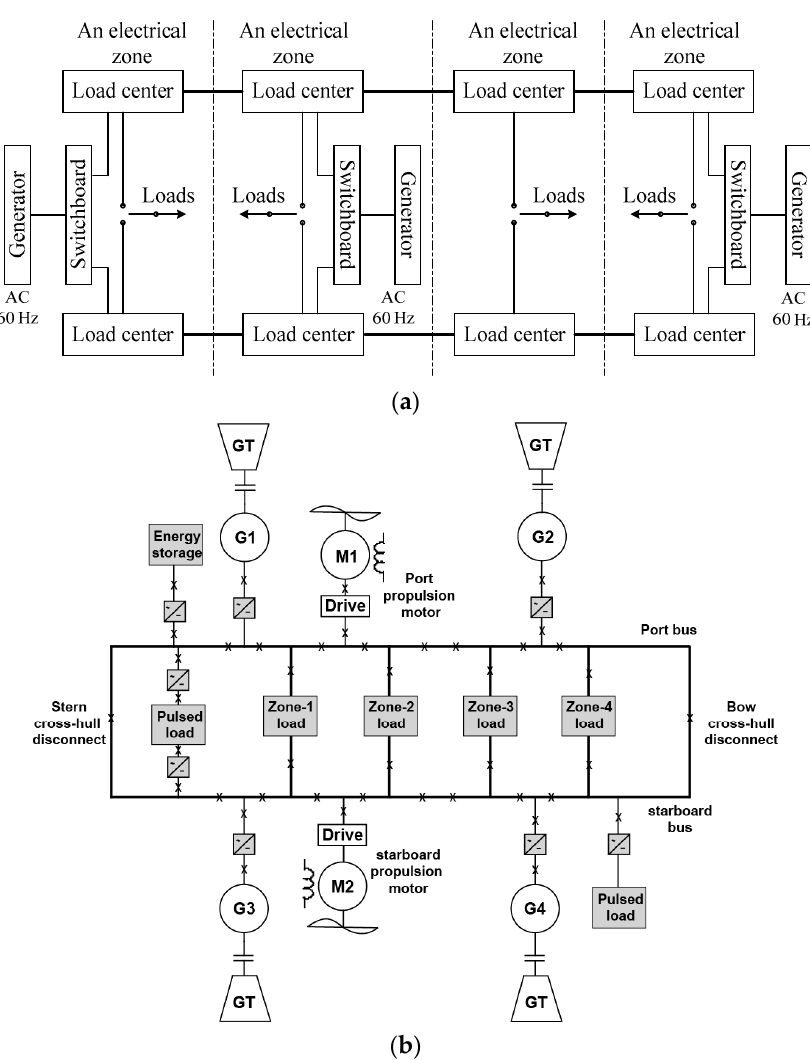
Figure 3. ( a ) AC zonal electrical distribution system (ac-ZEDS); ( b ) dc zonal electrical distribution system (dc-ZEDS) (GT—gas turbine, G—generator, M—Motor and L—load).